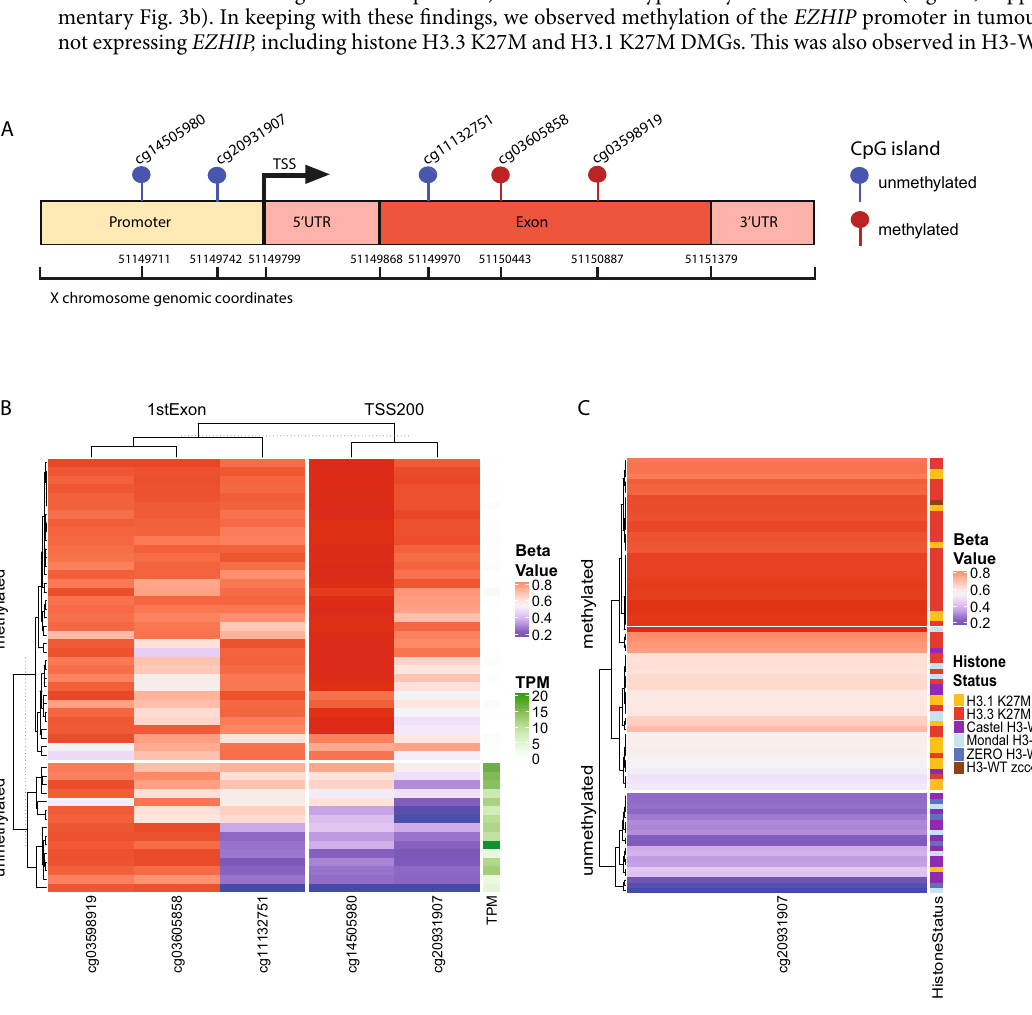
Figure 4. EZHIP expression is regulated by promoter methylation. ( A ) Lollipop depiction of the location of CpG islands on the Illumina EPIC 850 K methylation array that are located in either the 1st Exon or within 200 base pairs of the transcription start site (TSS200) of the EZHIP gene. The genomic coordinates are genome build hg19. CpG islands identified as unmethylated are blue and methylated red in H3-WT cohort. ( B ) Heatmap representation of the 5 CpG islands in EZHIP and the corresponding beta value for each ZERO glioma tumour sample and the TPM value (0 – white to 20 – dark green) for the corresponding sample. ( C ) Heatmap of the most correlated CpG island for ZERO, Mondal and Castel patients, with the histone status of each patient highlighted (H3.1 K27M – yellow; H3.3 K27M – red; Castel H3-WT – purple; Mondal H3-WT – light blue; ZERO H3-WT – blue; H3-WT zcc446 – brown). For B and C the beta value is a range between 0–1 with 0 (blue) being unmethylated, 1 (red) methylated and 0.5